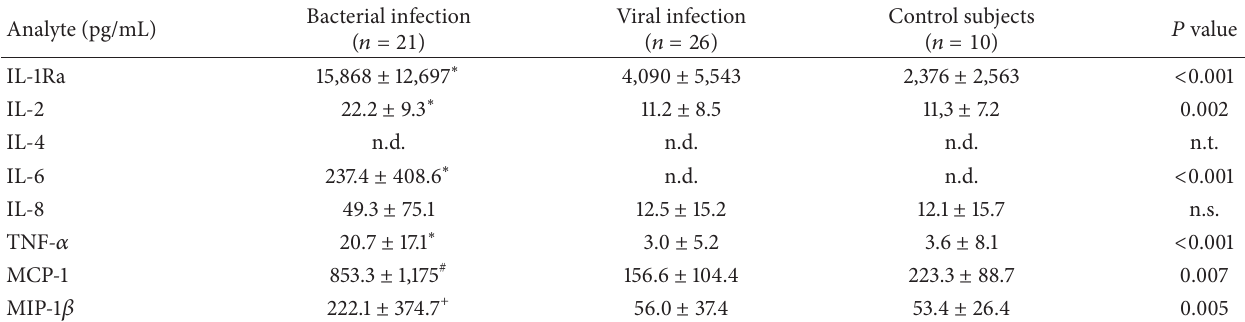
Table 3: Serum cytokine and chemokine levels.